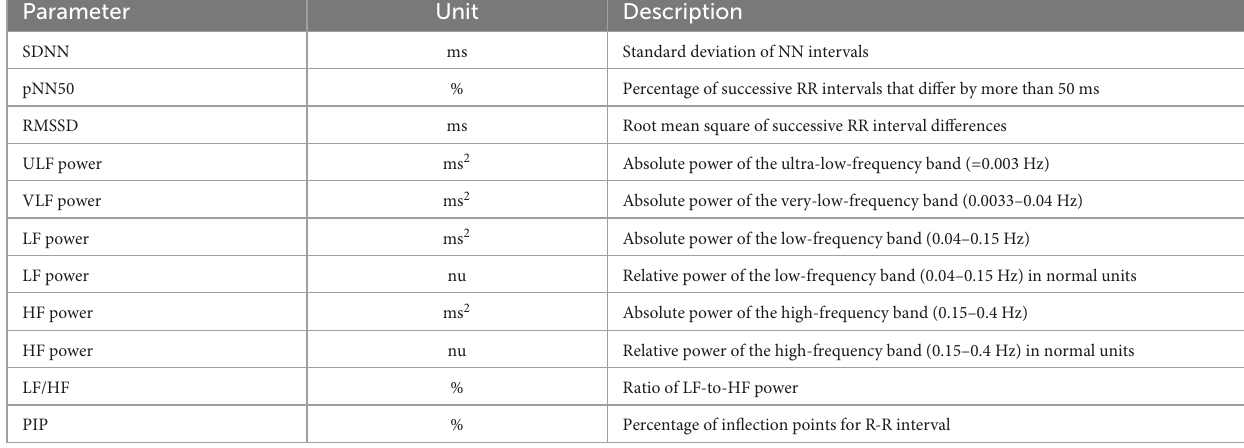
TABLE 1 Traditional HRV time-domain and frequency-domain measures and heart rate fragmentation